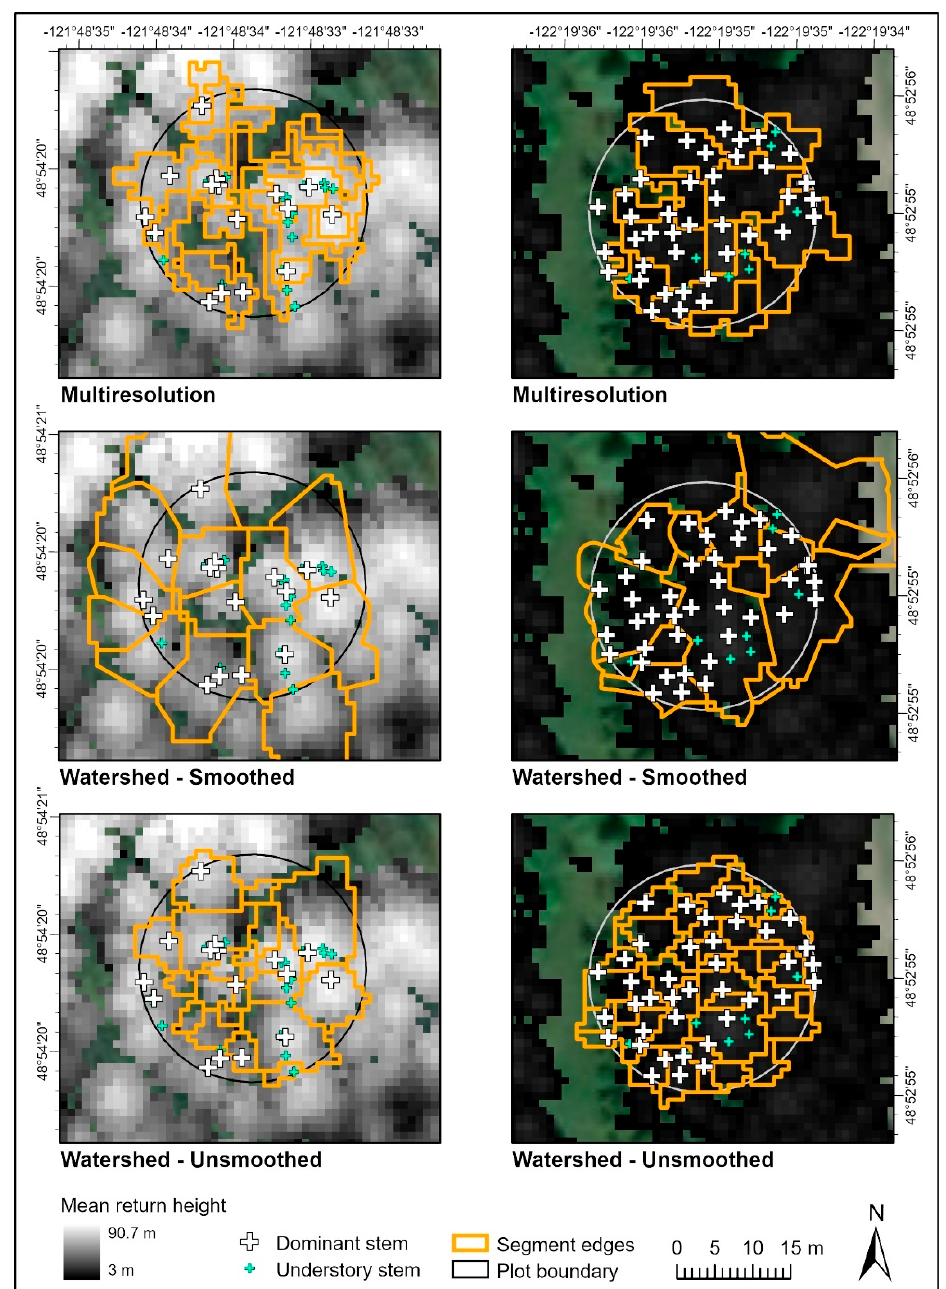
Figure 4. Examples of eCognition segmentation outputs for a plot with large coniferous trees in the upper North Fork (left panels) and a plot with densely spaced small conifers on the lower main fork (right panels). Segments produced using eCognition cannot overlap.